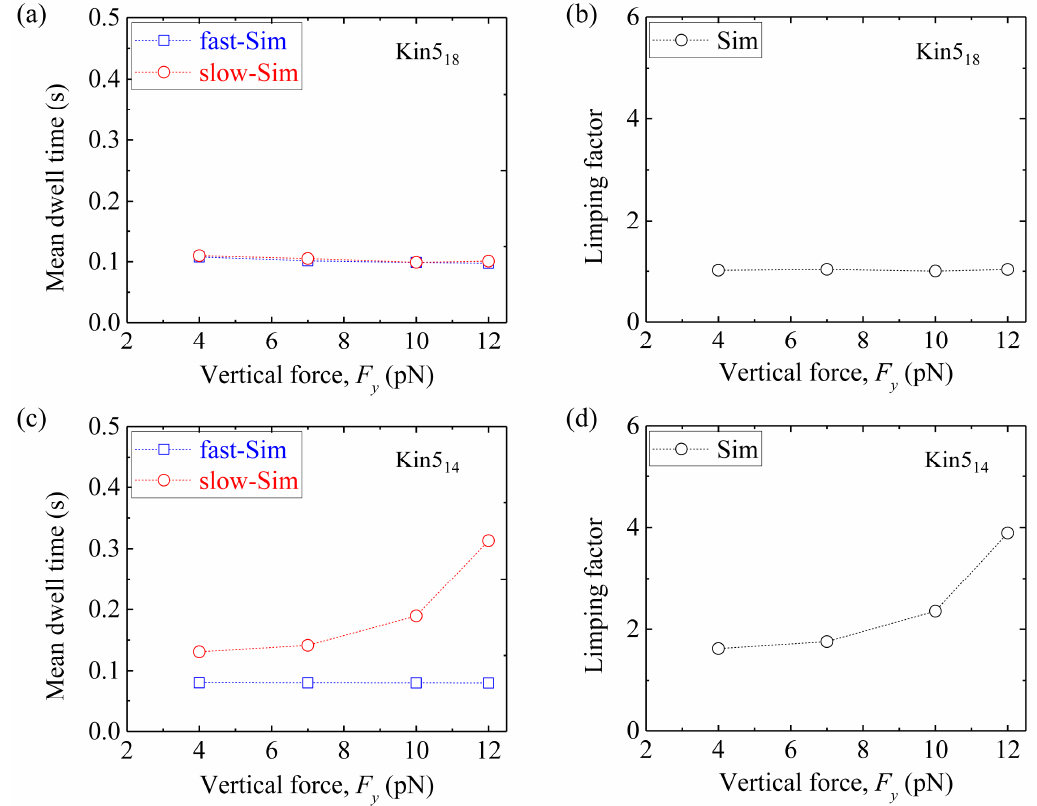
Figure 11. Limping effect of homodomeric kinesin-5 with and without shortening of NLs. F x = –3 pN and δ = 0.4 nm in the simulation. ( a ) The mean dwell time of the odd (red circles) and even stepping phases (blue squares) versus F y for Kin5 18 . ( b ) Limping factor versus F y for Kin5 18 . ( c ) The mean dwell time of the odd (red circles) and even stepping phases (blue squares) versus F y for Kin5 14 . ( d ) Limping factor versus F y for Kin5 14 .